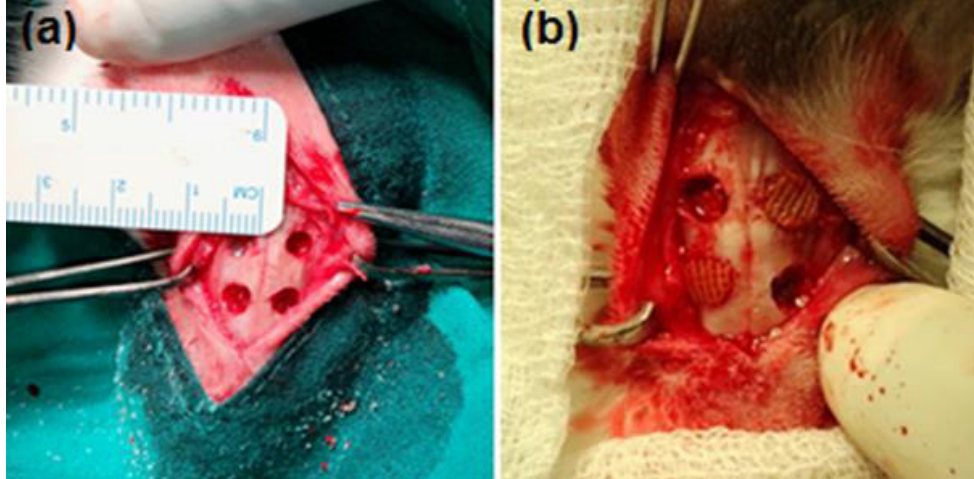
Figure 10. Schematic representation of the surgical procedure. ( a ) Four induced nasal critical-sized bone defects. ( b ) Example of how scaffolds were placed and the empty defects in the New Zealand White Rabbit.